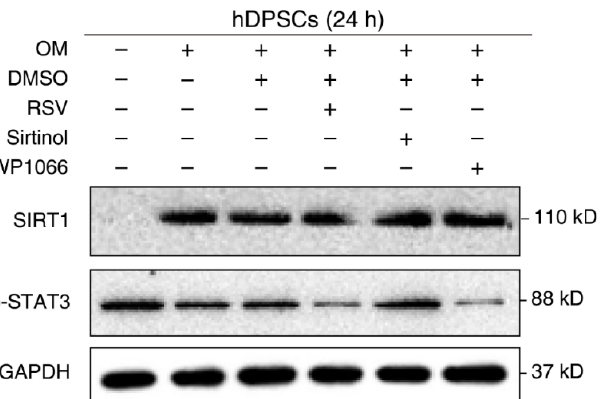
Figure 3. SIRT1 counteracted the activation of STAT3 in hDPSCs. hDPSCs were treated with the SIRT1 activator (resveratrol, RSV, 200 μ M) or inhibitor (sirtinol, 120 μ M) for 24 h, then subjected to Western blot examination. A STAT3 phosphorylation inhibitor (WP1066, 5 μ M) was used as a positive control for STAT3 inhibition. OM: Osteogenic induction medium, RSV: Resveratrol.